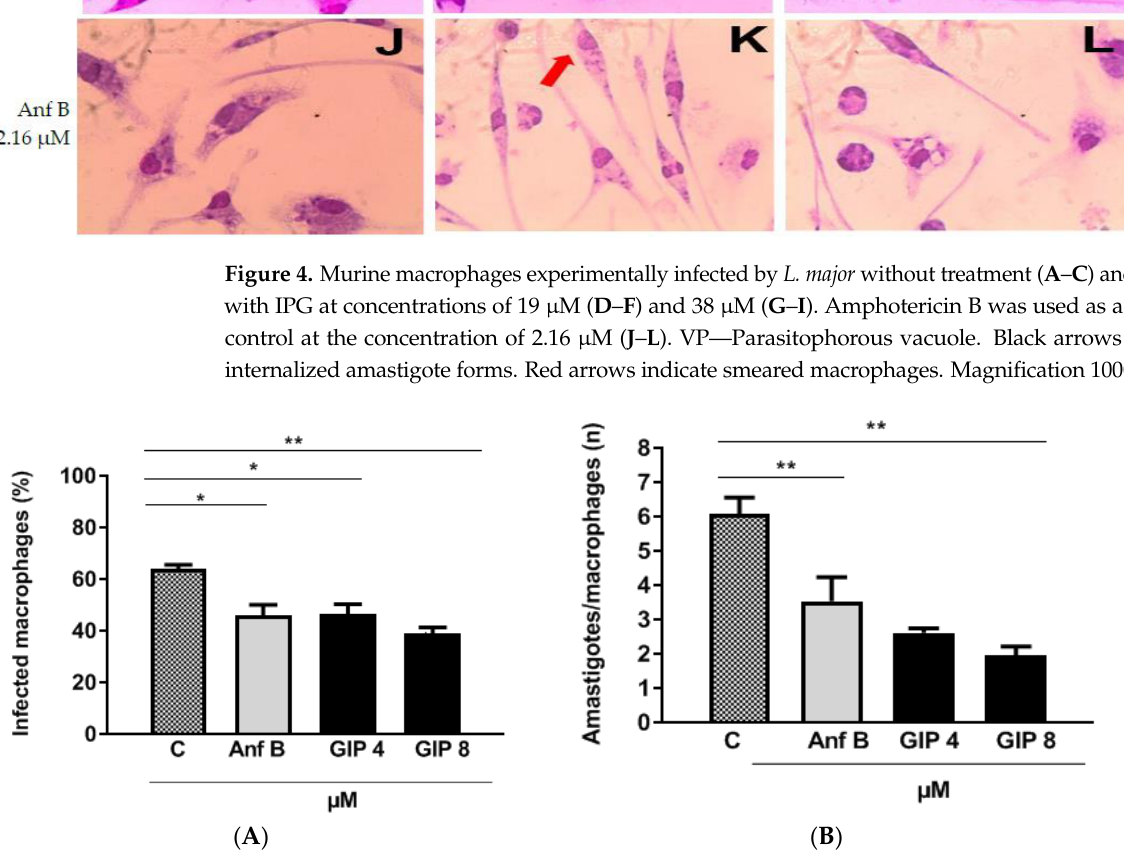
Figure 5. Effects of IPG and Anf B as a reference drug to assess infection (infected macrophages ( A ) and infectivity ( B ) in the treatment of murine macrophages infected with L. major . The percentage of infection after treatment ( A ) and the number of amastigotes per macrophage ( B ) were calculated by counting 100 cells in triplicate. Results are presented as mean ± SEM. of three independent experiments performed in triplicate, * p < 0.05, ** p < 0.01, when compared with control C, Anf B or the concentrations tested.